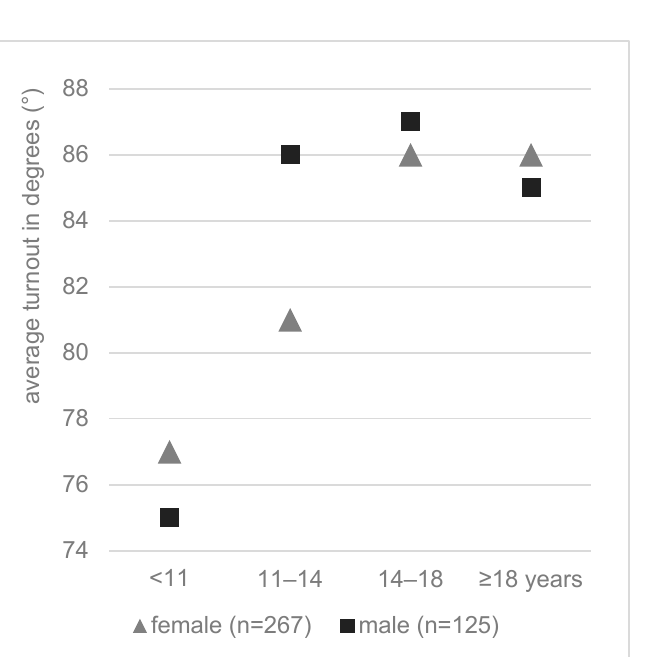
Figure 8. Average turnout by age group and gender.